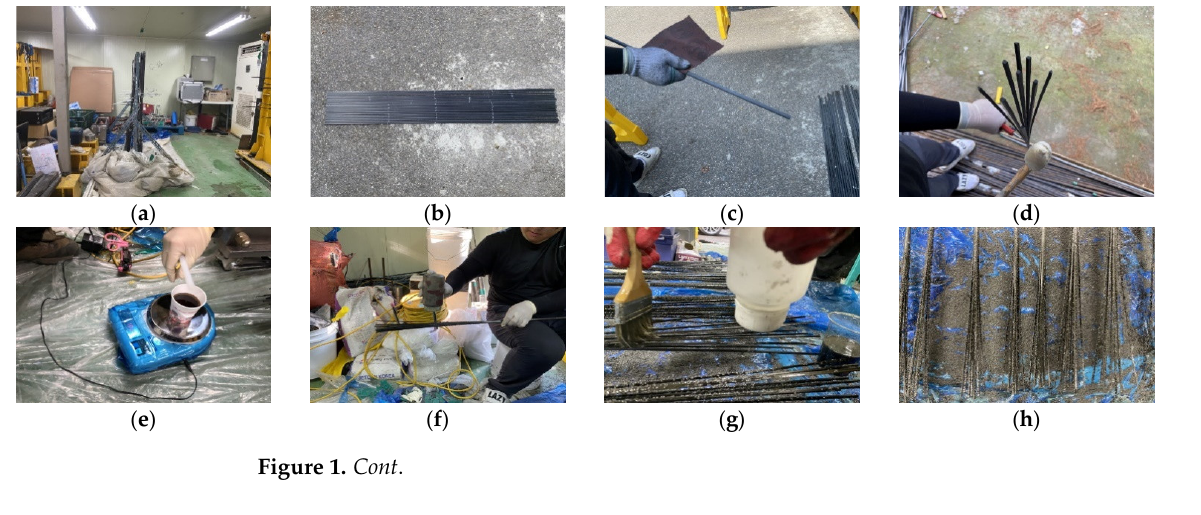
( p ) Figure 1. Preparation process for carbon fiber-reinforced polymer (CFRP) specimens used for tensile tests: ( a ) Assembly of holder, ( b ) CFRP cutting, and ( c ) CFRP interface treatment. ( d ) Division of CFRP specimen into nine equal parts. ( e ) Epovia resin mixer, ( f ) first oxide costing, ( g ) second oxide costing, ( h ) completion of oxide coating, ( i ) EPONDEX resin mixing, ( j ) resin coating of the FRP sheet, ( k ) completion of the FRP sheet attachment, ( l ) mounting of the specimen, ( m ) mixing of mortar, ( n ) specimen placement, ( o ) state after placement, and ( p ) completion of the test specimen preparation process. 2.3. Tensile Test Method with the Sample Specimens Figure 2 shows a sample specimen of the CFRP round steel pipe. The prepared specimen had a total length of 1500 mm, and the steel pipe had a length of 550 mm. The lengths of the nine equally divided CFRP parts were equal to 300 mm, and the lengths of the top and bottom ends in the center were equal to 400 mm.